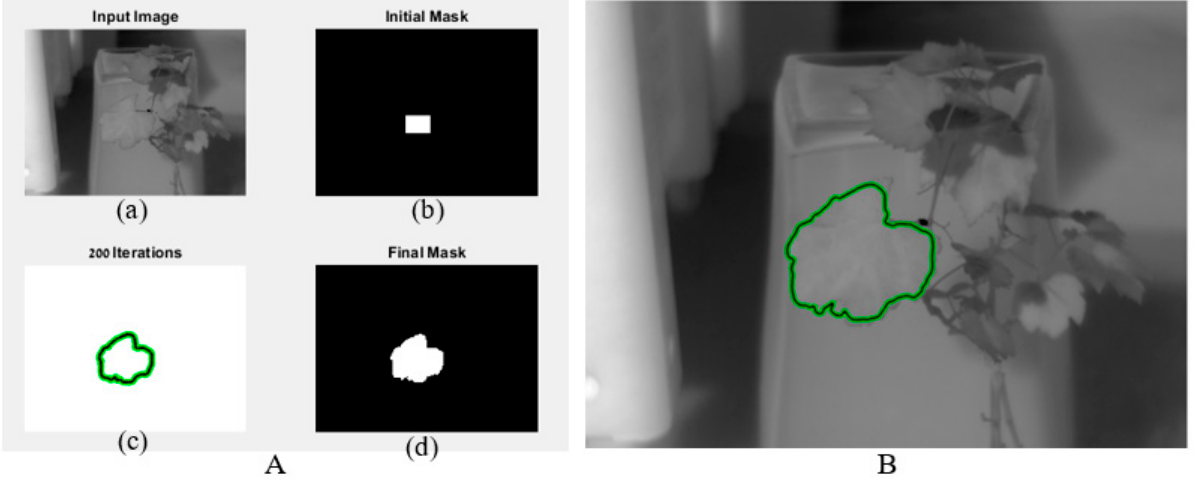
Figure 1. The output of the active contour algorithm. ( A ) includes image, initial, and final mask; ( B ) image with final mask.